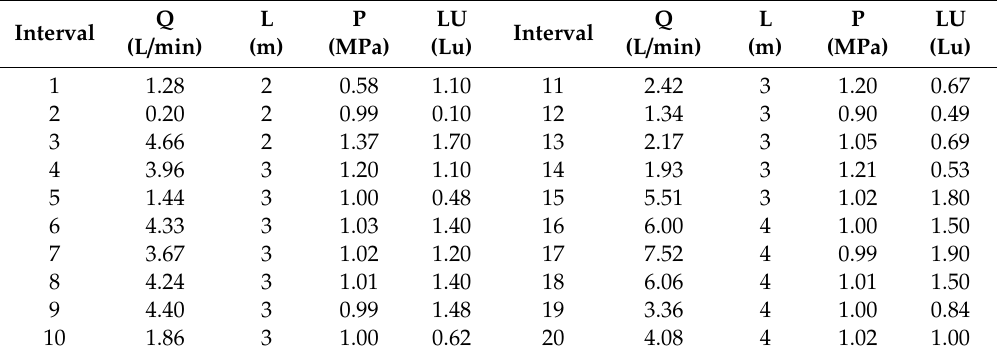
Table 3. Permeability value of verification hole DJ1-1.